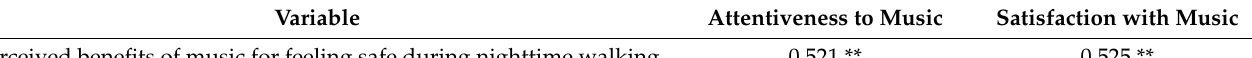
Table 10. Correlation between the perceptions of the music listened to and the benefits or interference of music listening during nighttime walking ( n = 78).